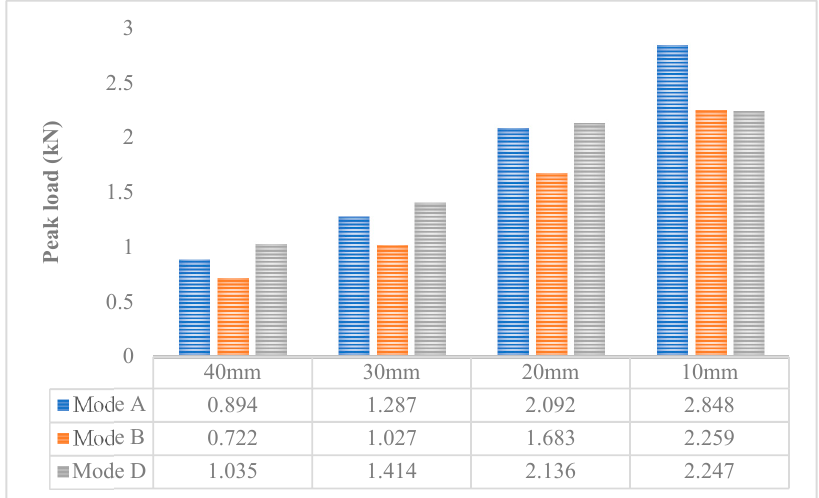
Figure 10. The peak load results of the virtual Arcan test with different notch lengths and different mixed-mode levels.